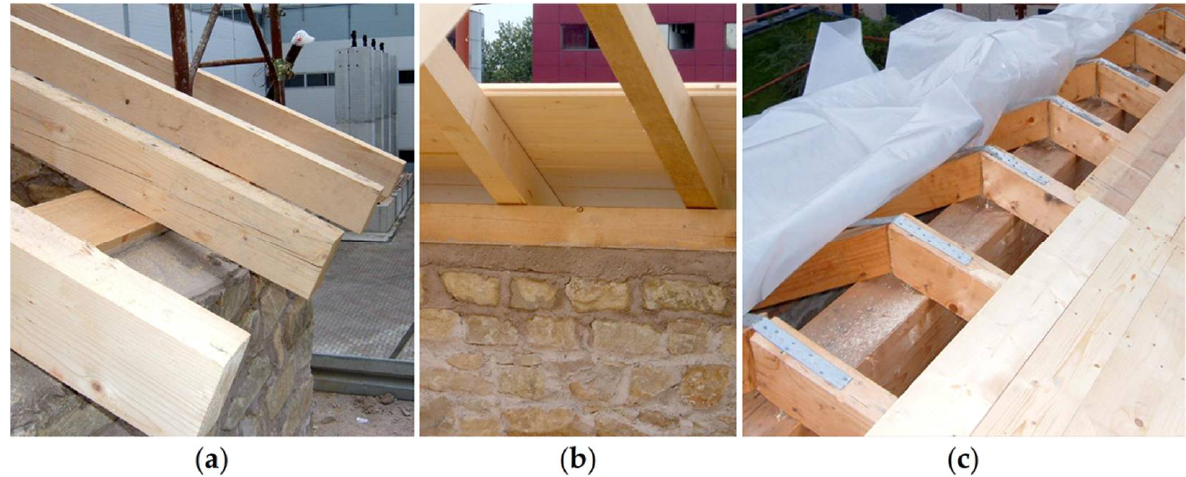
Figure 5. Timber roof: ( a ) rafters resting on the spreader beam above longitudinal walls; ( b ) inside view of the spreader beam, rafters, and nailed timber planks; ( c ) rafters supported by the ridge beam and connected by perforated steel plates.